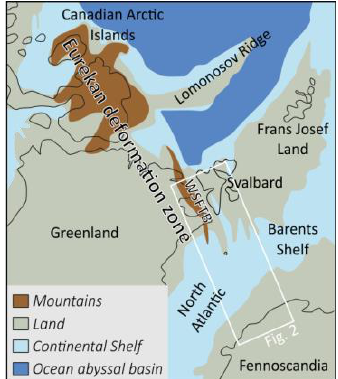
Figure 1. Eocene palaeogeography reconstruction showing the extent of the Eurekan relief after Blakey [4] and Smelror, et al. [5]. WSFTB = West Spitsbergen fold-and-thrust Belt. The location of the study site and region covered by Figure 2 is indicated.